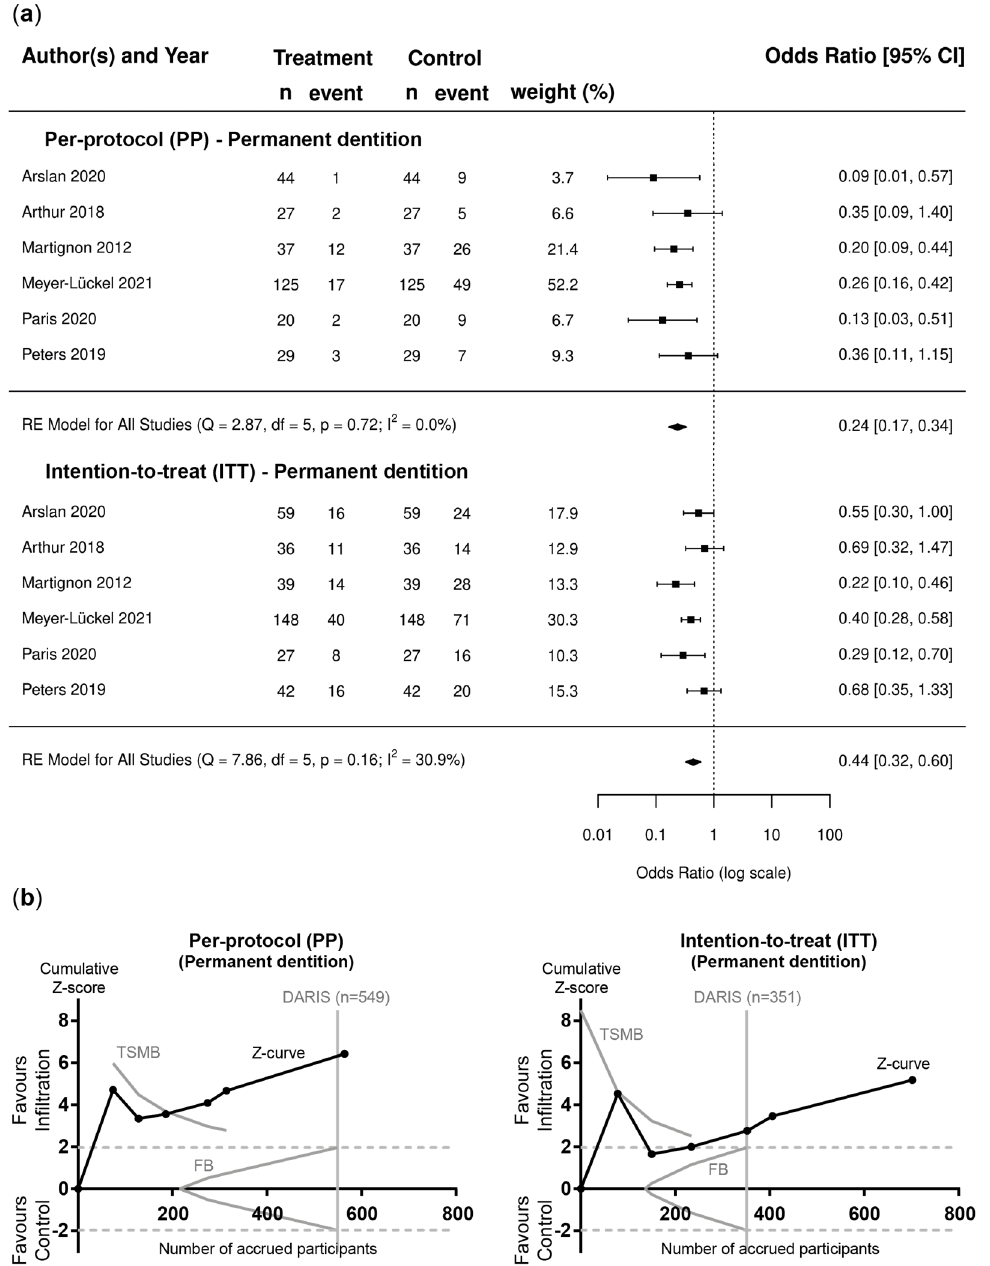
Figure 2. Permanent dentition. ( a ) Forest plots of pairwise meta-analysis for PP and ITT scenarios. Risk of failure, i.e., lesion progression, is indicated for lesions in permanent teeth treated with resin infiltration and non-invasive measures compared to placebo and non-invasive measures [57–62]. The odds ratio (OR) and 95% confidence intervals (CI) are shown. Heterogeneity is indicated by I 2 and Q statistics. Diamonds indicate pooled effect estimates. The number of lesions was adjusted using the design effect as described. ( b ) Trial sequential analysis (TSA) of trials evaluating lesions in permanent teeth [57–62] for PP and ITT scenarios to assess the robustness of evidence. The cumulative Z-score (black curve), i.e., the accumulated level of significance, was plotted against the number of participants accrued so far, which was compared with the heterogeneity-adjusted required information size (DARIS), the conventional border (Z = 1.96), the trial sequential monitoring boundary (TSMB), and the futility border (FB) (grey oblique). For both scenarios, i.e., PP and ITT, the Z-curve crossed the conventional border and TSMB before reaching DARIS.